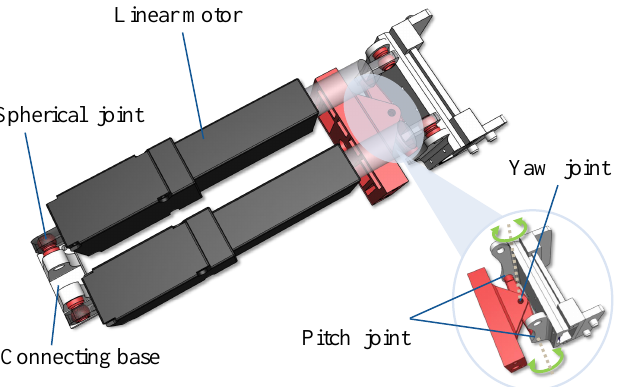
Figure 4. The joint with two DoFs.